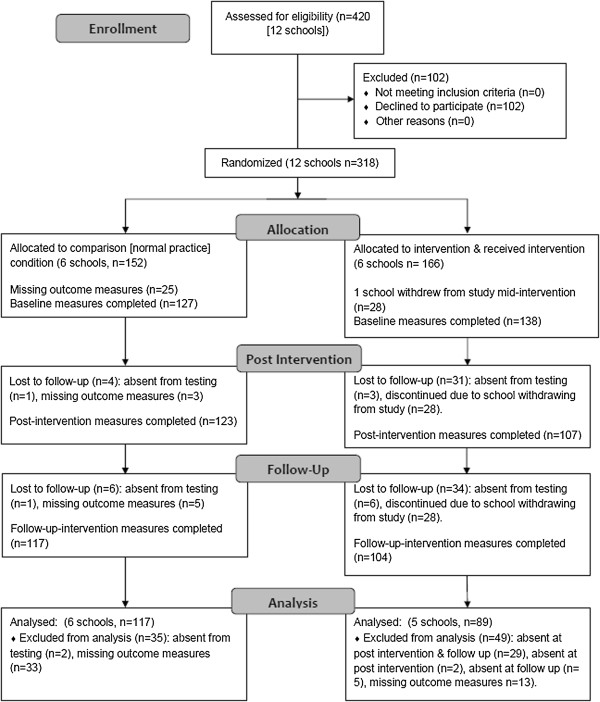
Flow of schools and participants through the study.